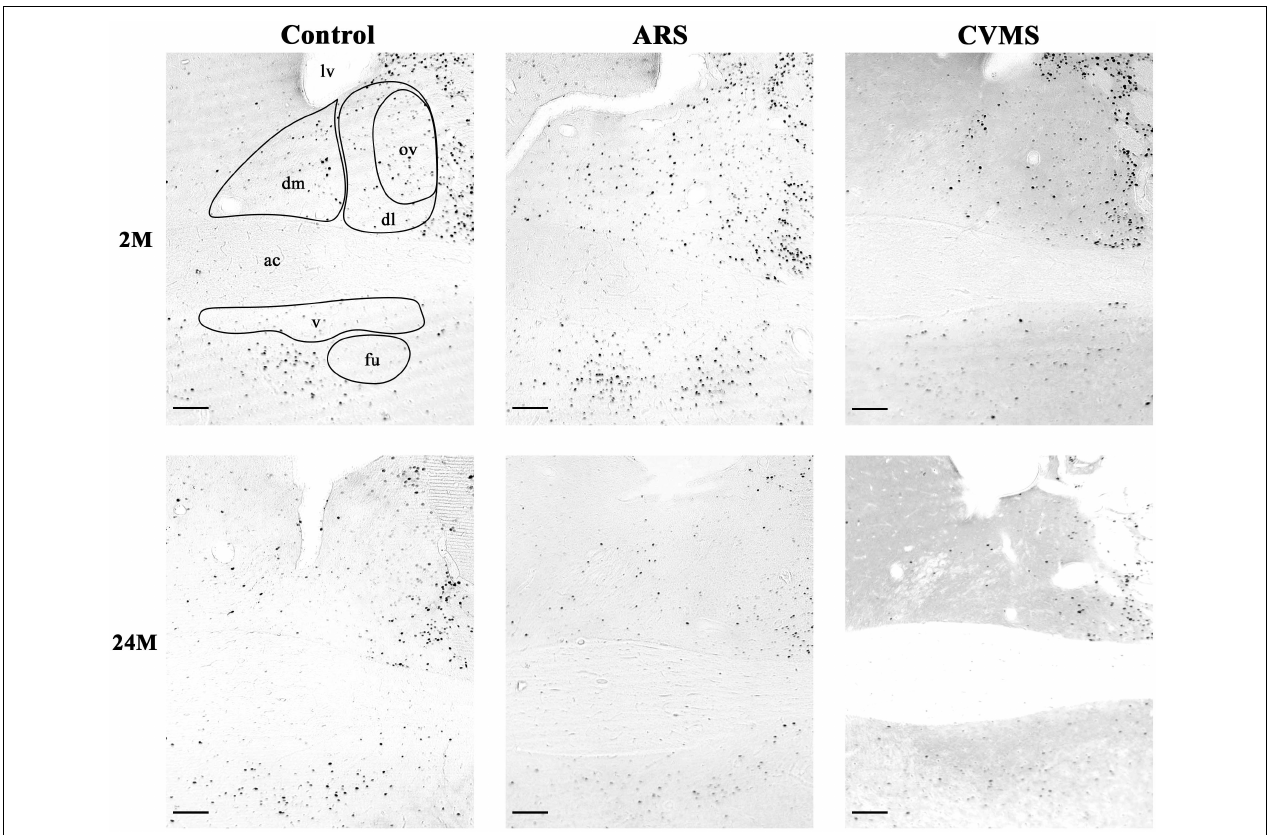
FIGURE 3 | Representative photos of age-dependent FOSB/ (cid:49) FOSB immunoreactivity in the bed nucleus of the stria terminalis (BNST) in acute restraint stress (ARS)-exposed and chronic variable mild stress (CVMS)-subjected rats at 2-months-old (M) and at 24 M at –0.12 mm to the Bregma. dm, dorsomedial division of BNST; dl, dorsolateral division of BNST; ov, oval division of BNST; v, ventral division of BNST; fu, fusiform division of BNST; ac, anterior commissure; lv, lateral ventricle. Scale bar: 100 µ